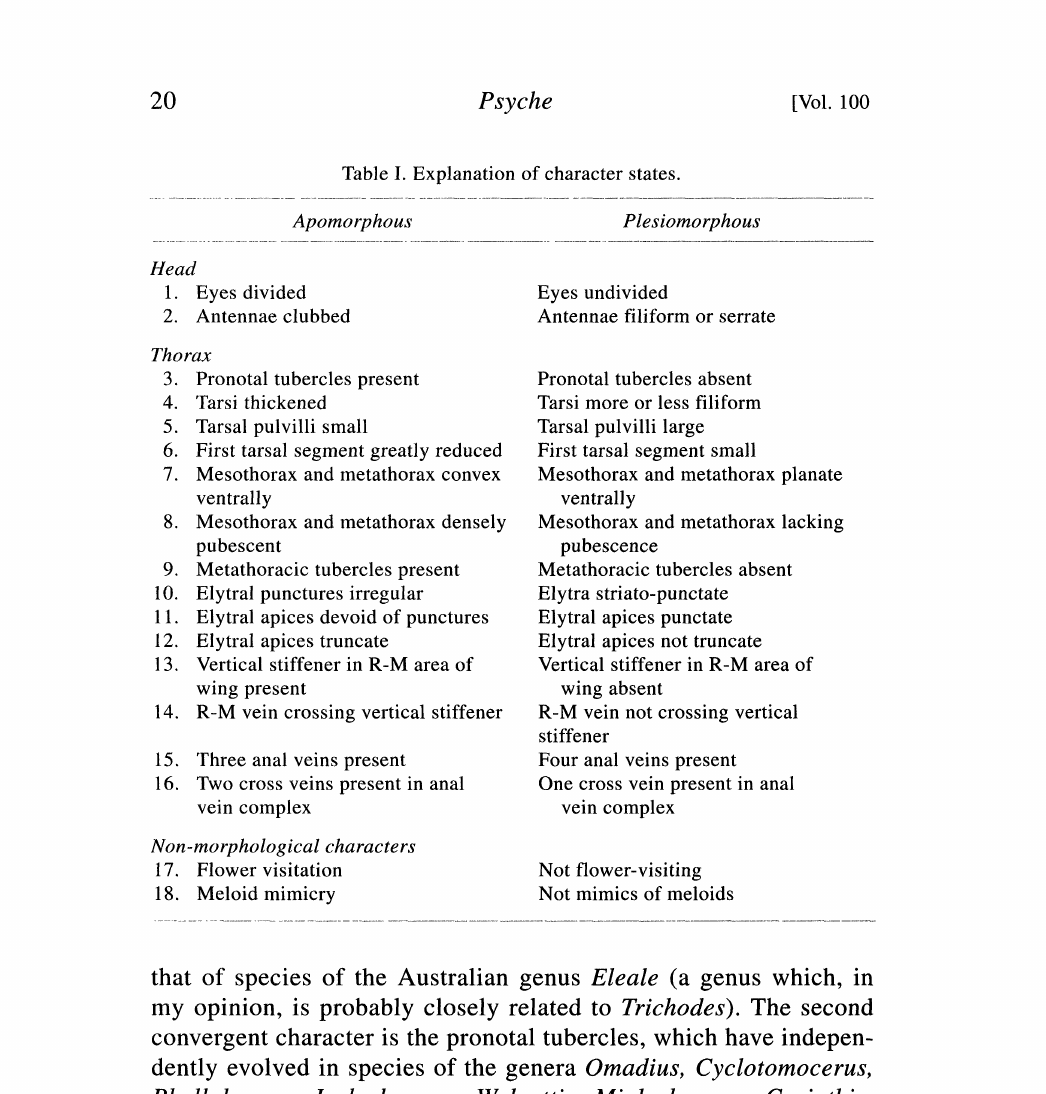
Table I. Explanation of character